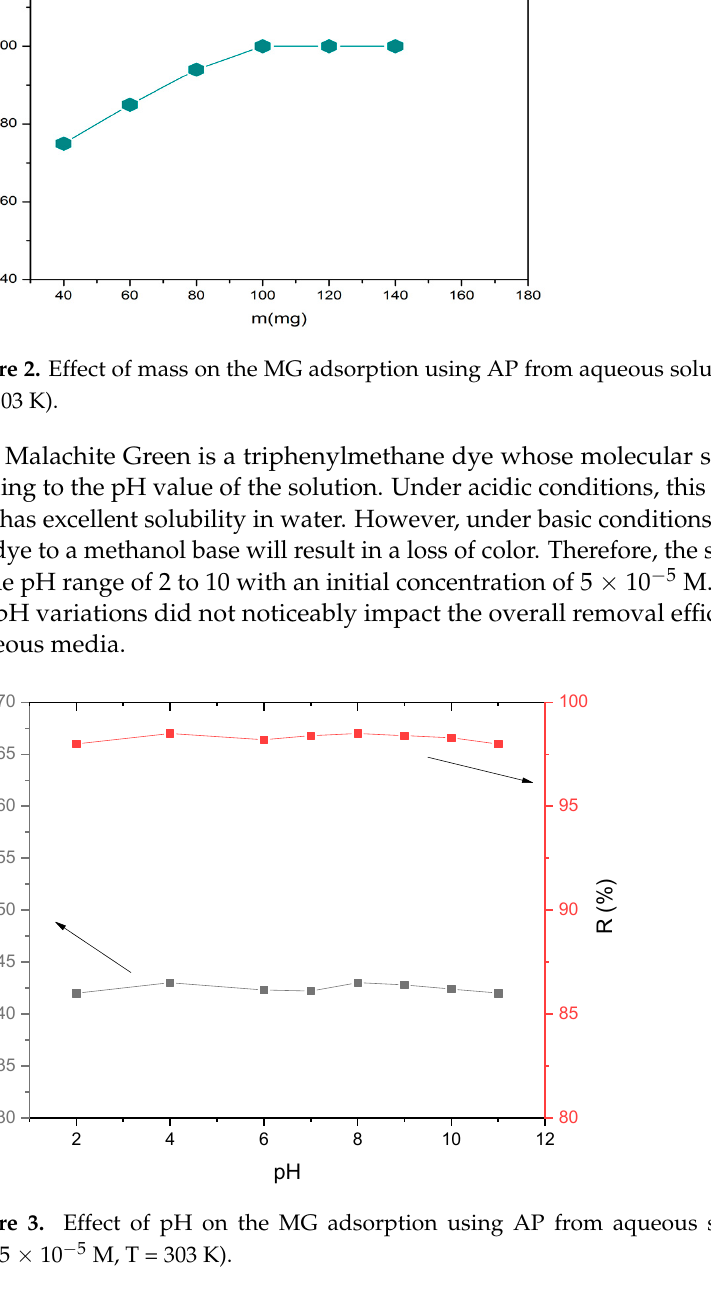
Figure 3. Effect of pH on the MG adsorption using AP from aqueous solution (m = 0.1 mg, Ci = 5 × 10 − 5 M, T = 303K).